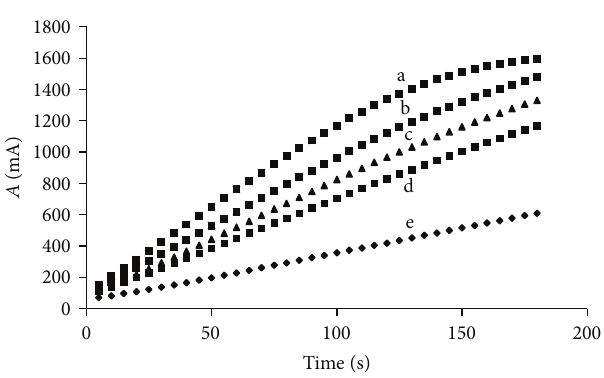
Figure 4: PH influence on the calibration curve. a: pH 7.0: Δ𝐴Δ𝑡 −1 ( mAs −1 ) = (0.44 ± 0.02) × 𝐶 ( mM ) + (0.2 ± 0.1) , 𝑟 = 0.999 , b: pH 7.5: Δ𝐴Δ𝑡 −1 ( mAs −1 ) = (0.433 ± 0.009) × 𝐶 ( mM ) + (0.15 ± 0.05) , 𝑟 = 0.9998 , and c: pH 6.5: Δ𝐴Δ𝑡 −1 ( mAs −1 ) = (0.44 ± 0.02) × 𝐶( mM ) + (0.0 ± 0.1) , 𝑟 = 0.9991 .